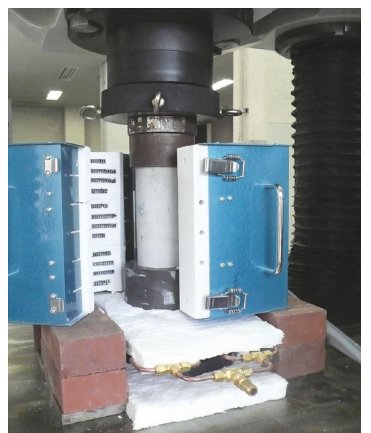
Figure 3: Setup for heating compression test.